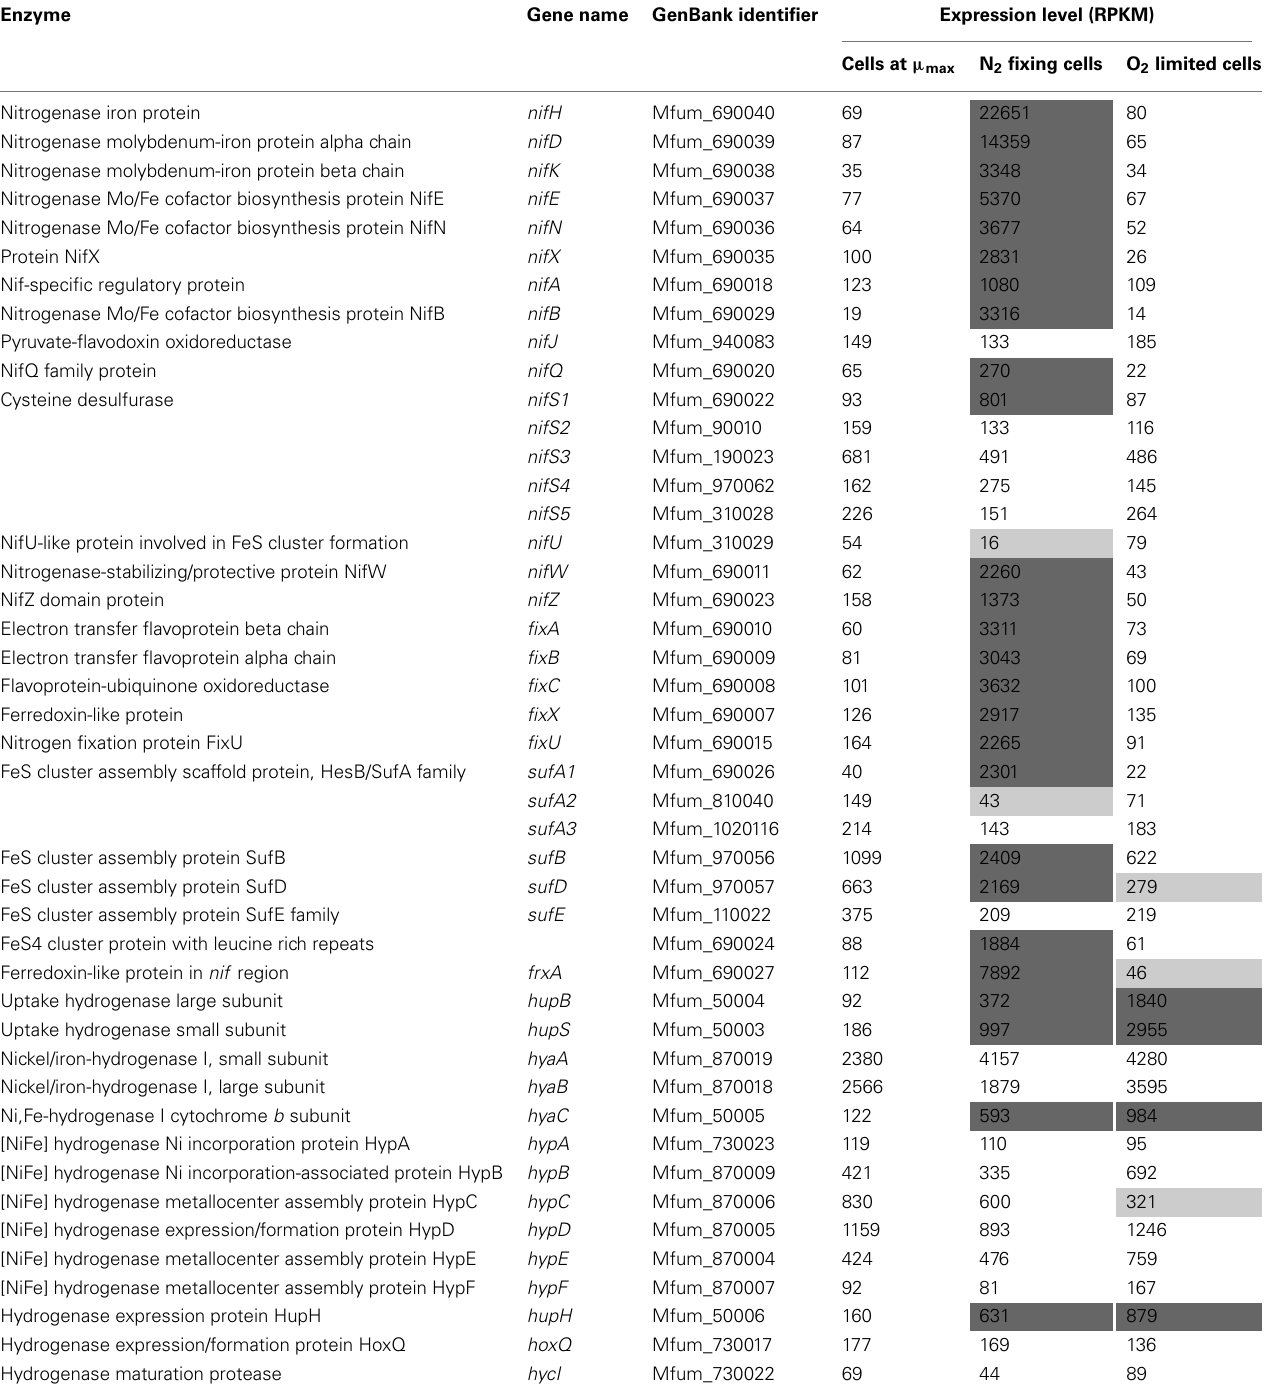
Table 4 |Transcription of genes involved in nitrogen fixation in “ Ca. M. fumariolicum ” strain